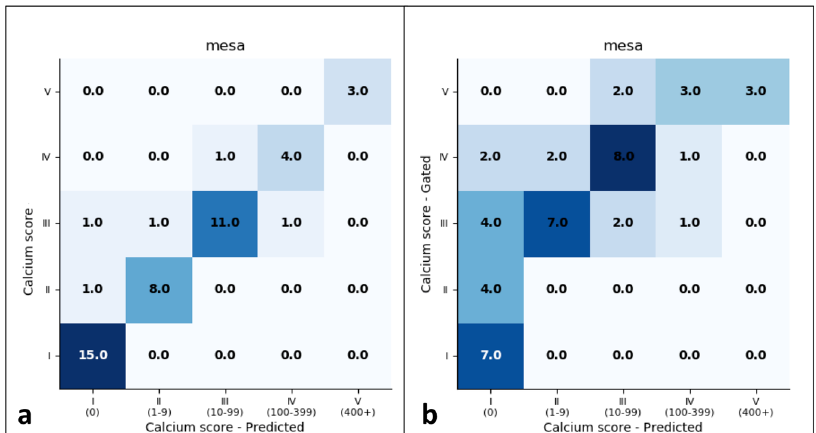
Fig. 8 Confusion matrices for non-gated model performance on the MESA test set based on ground truth method chosen. The left matrix ( a ) compares model prediction to scores derived from manual segmentations on non-gated chest CT exams while the right matrix ( b ) compares model predictions to scores derived from gated coronary CT exams, the clinical reference standard for CAC scoring. Note the performance differences (higher on the left) based on ground truth